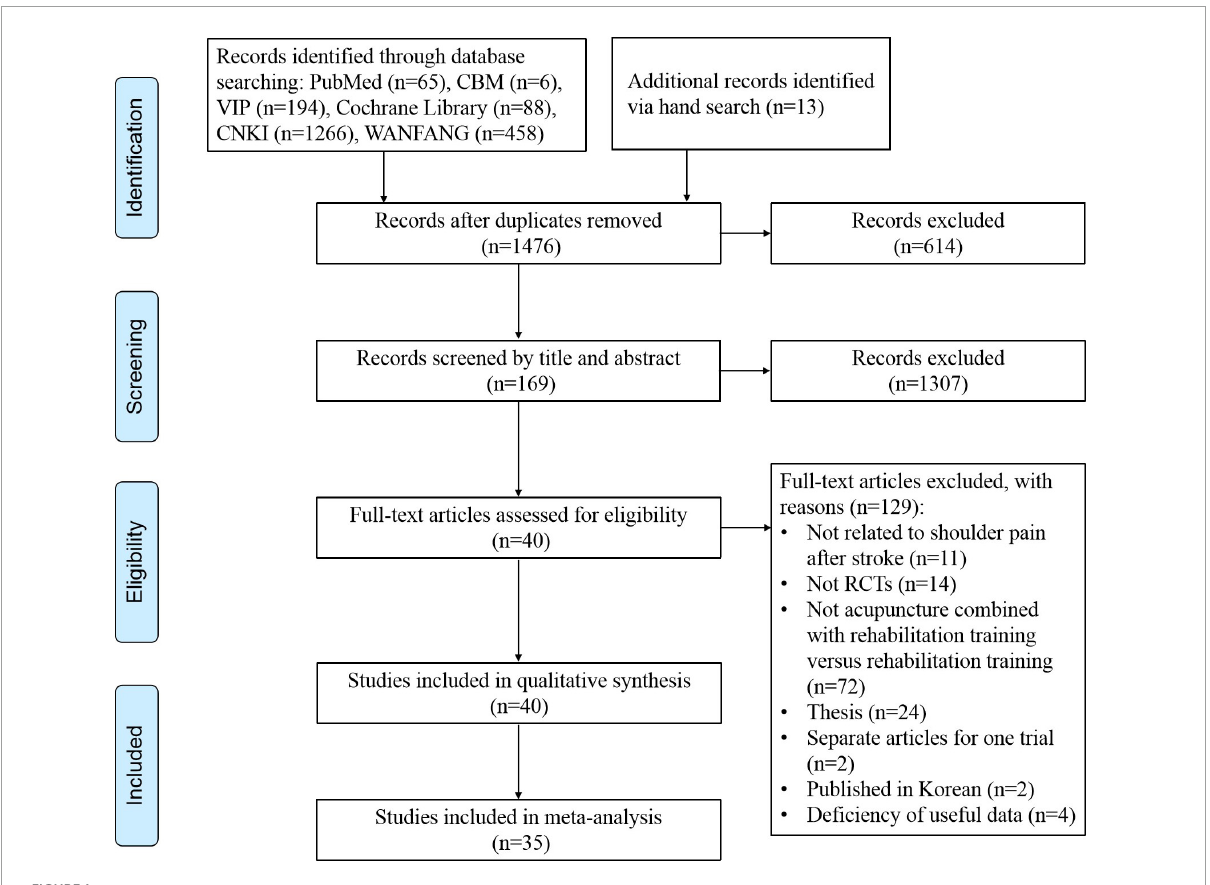
FIGURE1 Study flow